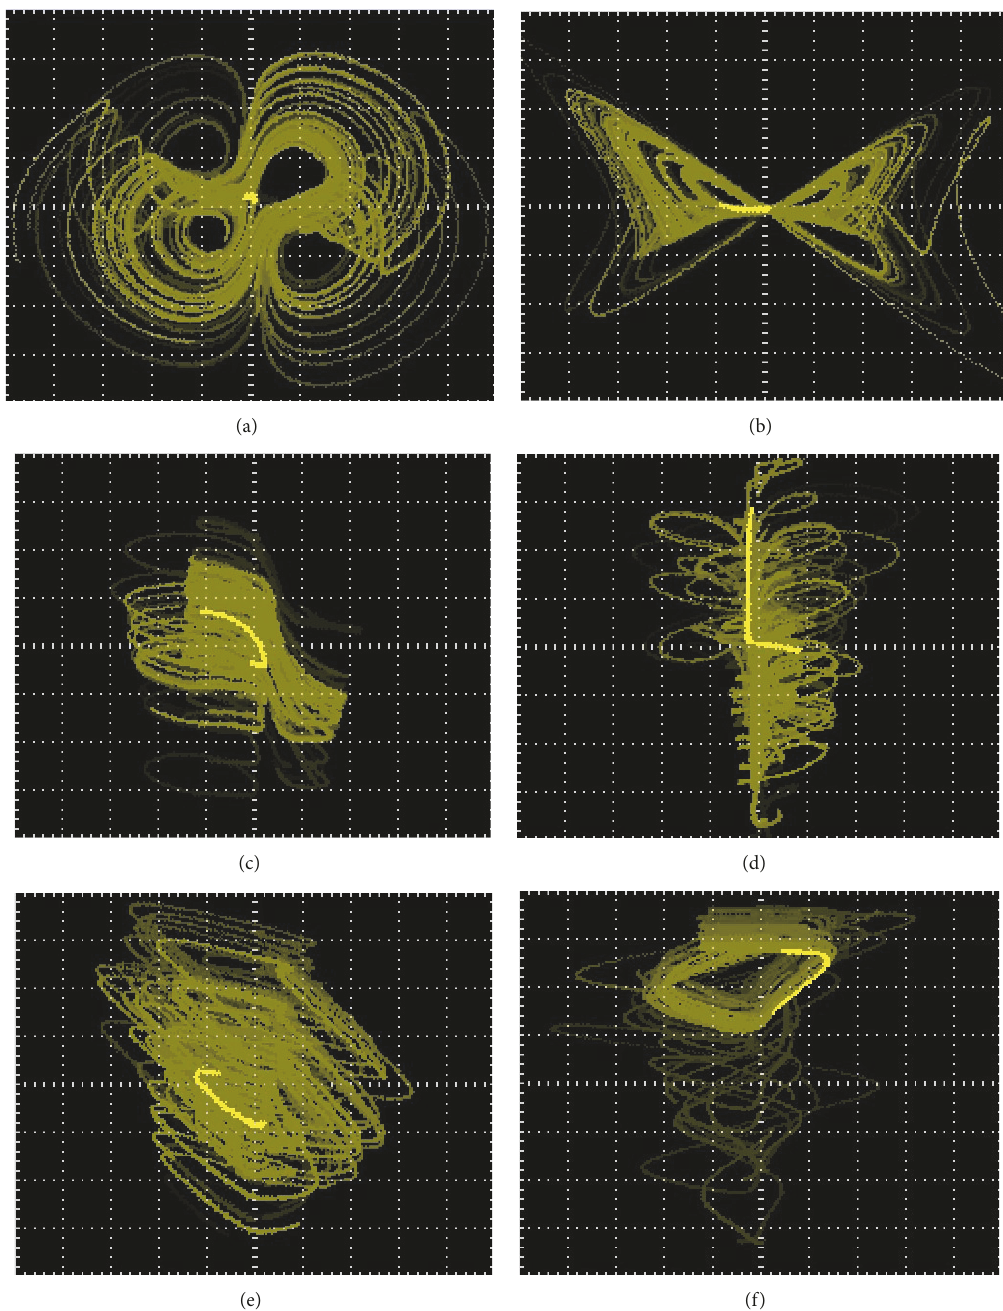
Figure 7: Physical circuit implementation hardware and digital oscilloscope diagrams of the chaotic System (17): (a) x-y plane with scales 2 V /div and 1 V /div, (b) x-z plane with scales 2 V /div and 1 V /div, (c) x-w plane with scales 2 V /div and 1 V /div, (d) z-w plane with scales 1 V /div and 1 V /div, (e) y-w plane with scales 1 V /div and 1 V /div, and (f) y-u plane with scales 1 V /div and 2 V /div.